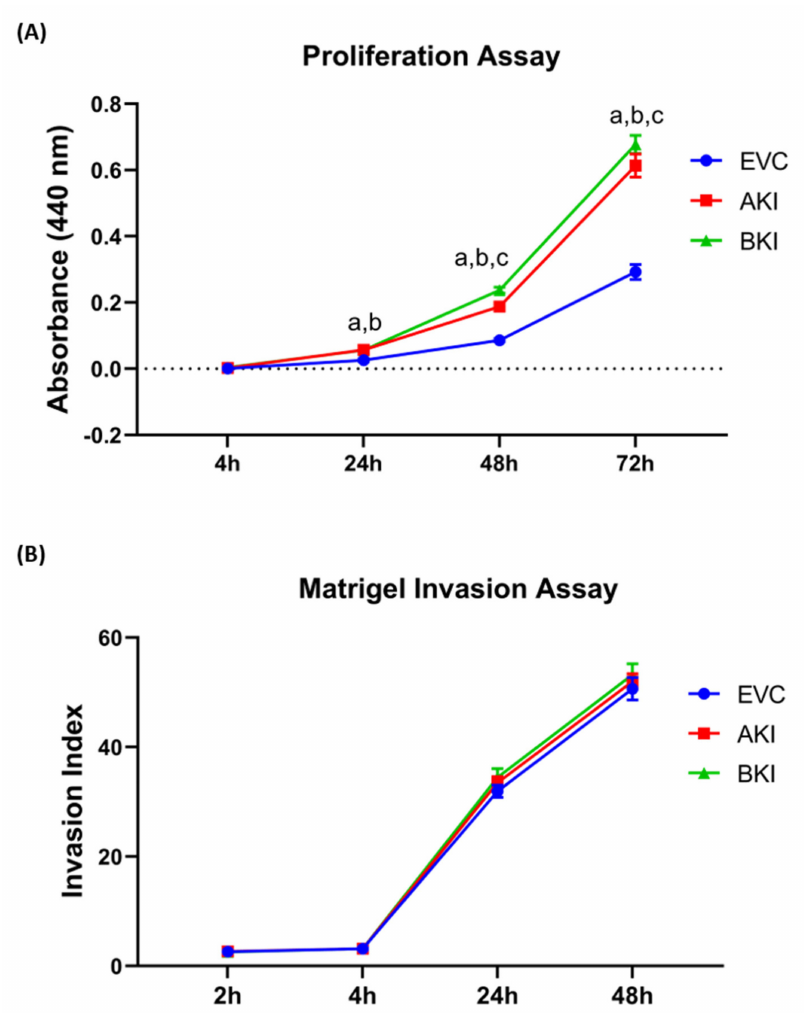
Figure 11. ( A ) Proliferation of AKI, BKI, and EVC iOTR cells ( n = 4 / treatment) was measured after 4 h, 24 h, 48 h, and 72 h using Quick Cell Proliferation Assay Kit. ( B ) Invasion of AKI, BKI, and EVC iOTR cells ( n = 4) measured after 2 h, 4 h, 24 h, and 48 h using the Matrigel Invasion Assay Kit; where a, p < 0.05 for AKI vs. EVC; b, p < 0.05 for BKI vs. EVC; and c, p < 0.05 for BKI vs.